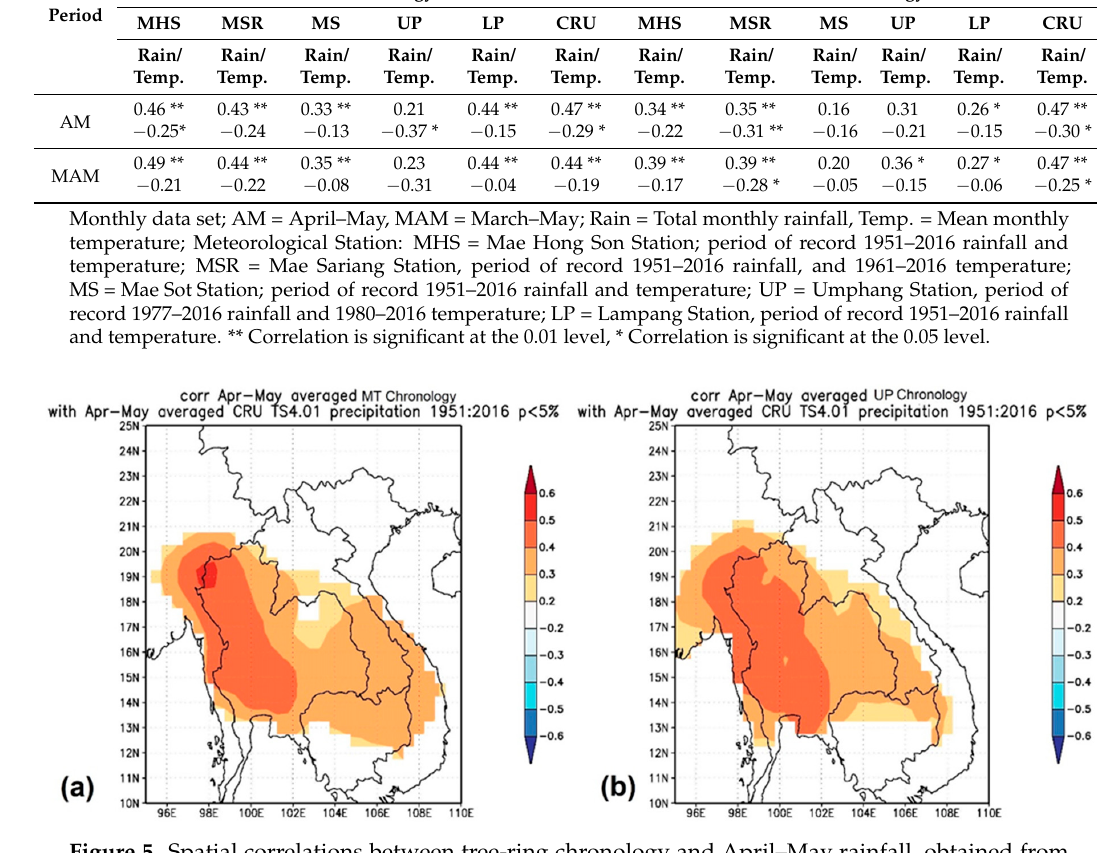
Figure 5. Spatial correlations between tree-ring chronology and April–May rainfall, obtained from CRU TS 4.01 data set for the period 1951–2016. ( a ) MT chronology. ( b ) UP chronology.